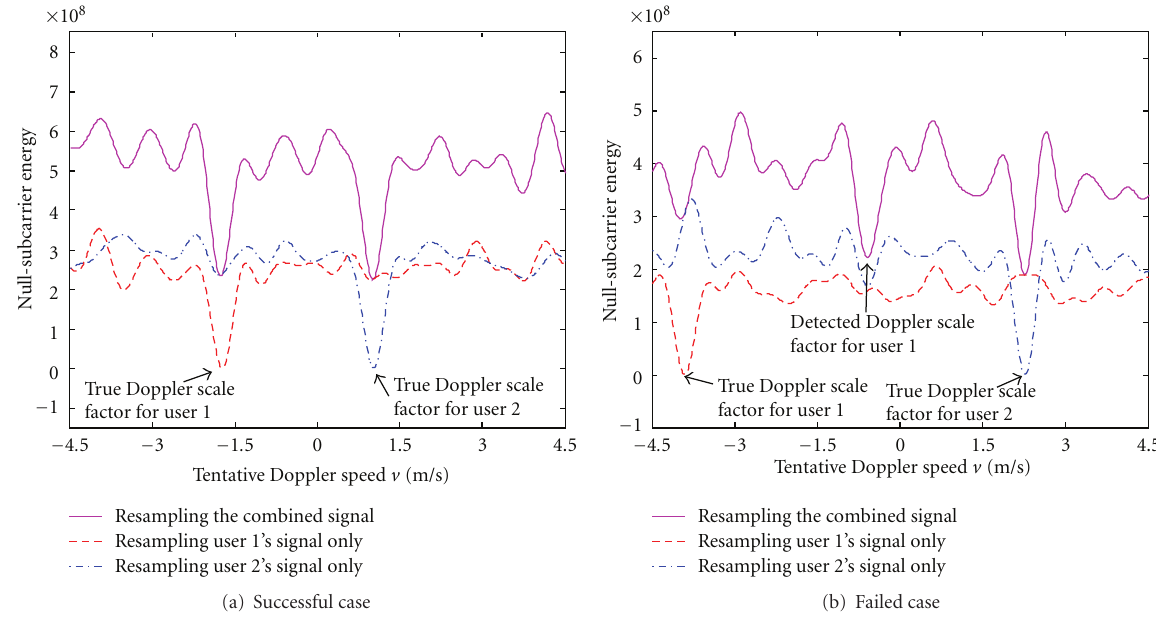
Figure 13: Illustration of the objective functions of the null-subcarrier-based method in a two-user